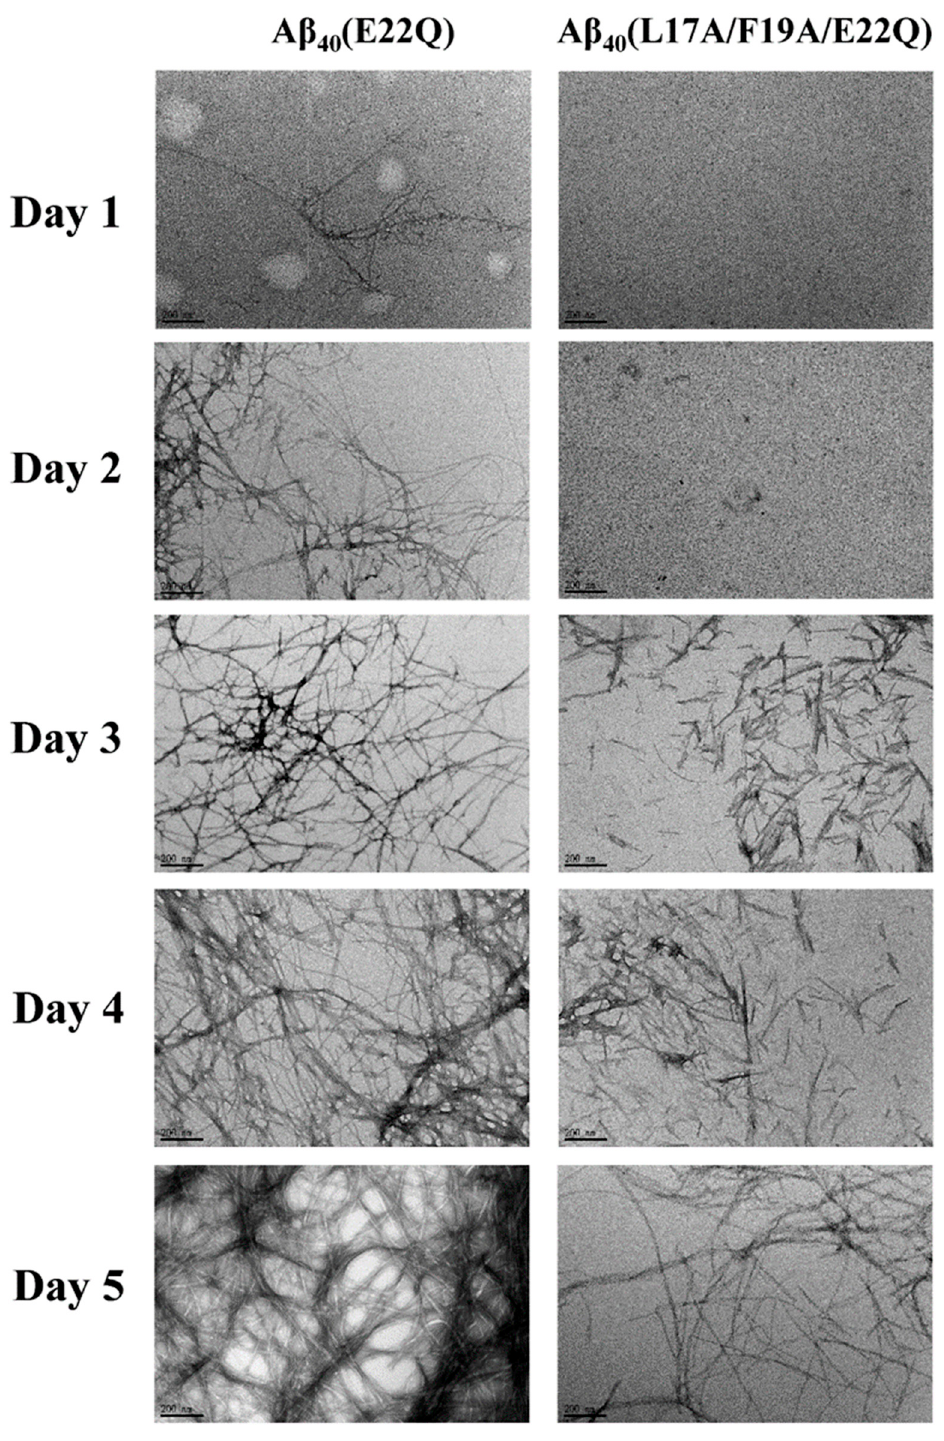
/ F19A / E22Q). The scale bar is 200 β 40 (E22Q) and A 40 (L17A